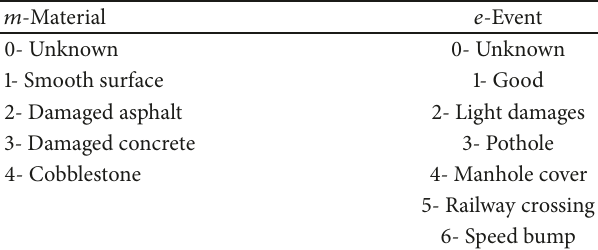
Table 1: Code and corresponding name of the classes for material and